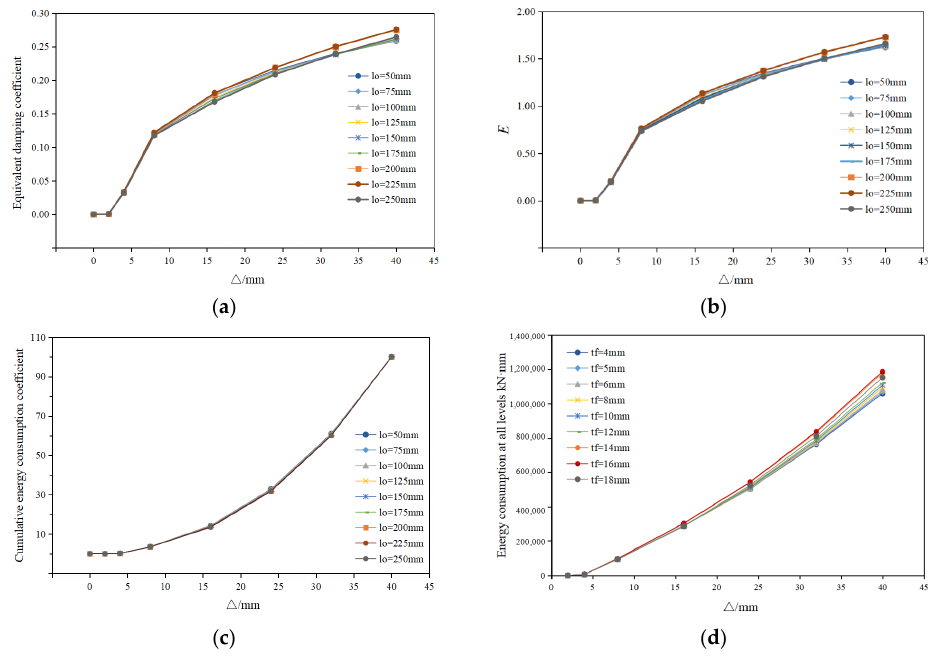
Figure 7. Correlation curve of the energy dissipation capacity of models with different fishplate thicknesses. ( a ) Equivalent damping coefficient; ( b ) energy dissipation coefficient; ( c ) cumulative energy dissipation coefficient; ( d ) energy dissipation at each stage. Table 6. Energy dissipation coefficient for models with different fishplate thicknesses.